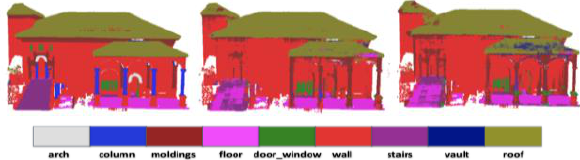
Figure 7. Qualitative outcomes for semantic segmentation of “B SMV chapel 27to35” while training with three scenes from the ArCH Dataset. The picture in each column represents the same meaning as each column of Figure 6.